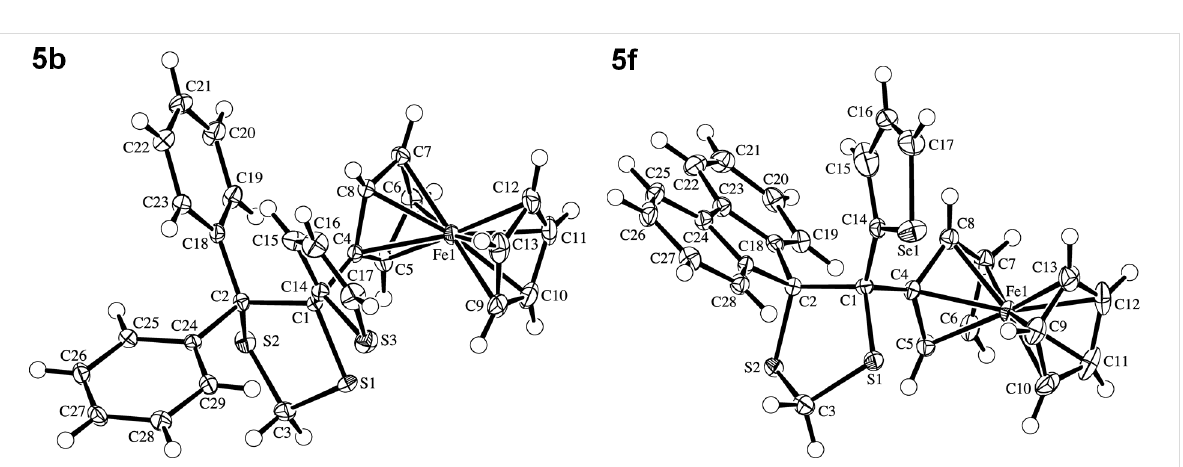
Figure 1: ORTEP Plot [16] of the molecular structures of the ferrocenyl-substituted 1,3-dithiolanes 5b and 5f (with 50% probability ellipsoids; arbitrary numbering of the atoms; only the major disorder conformation of the selenophene ring is